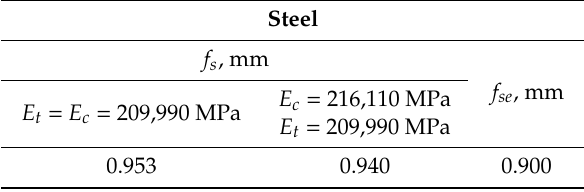
Table 1. The theoretical and experimental value of the maximum deflection of a steel beam.